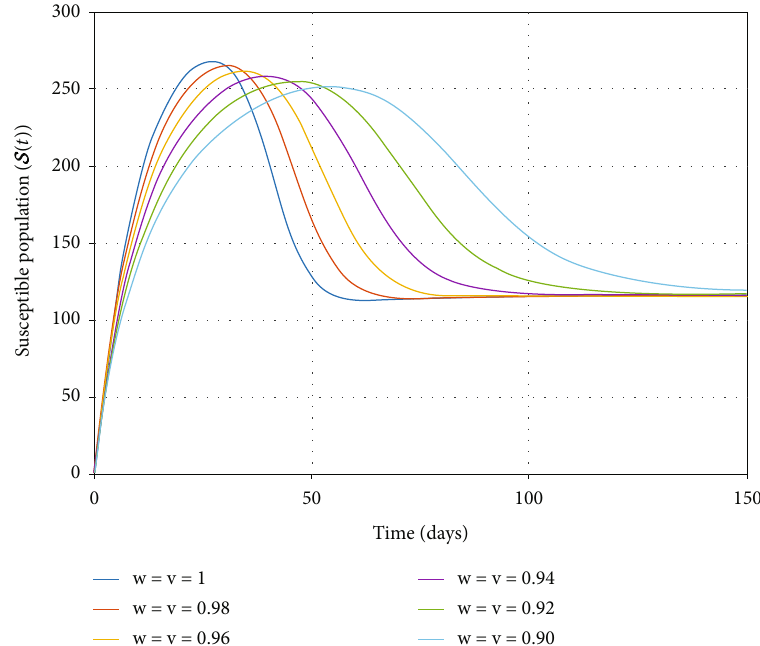
Figure 4: Behavior of S ð t Þ by changing fractal-fractional order ω and v .